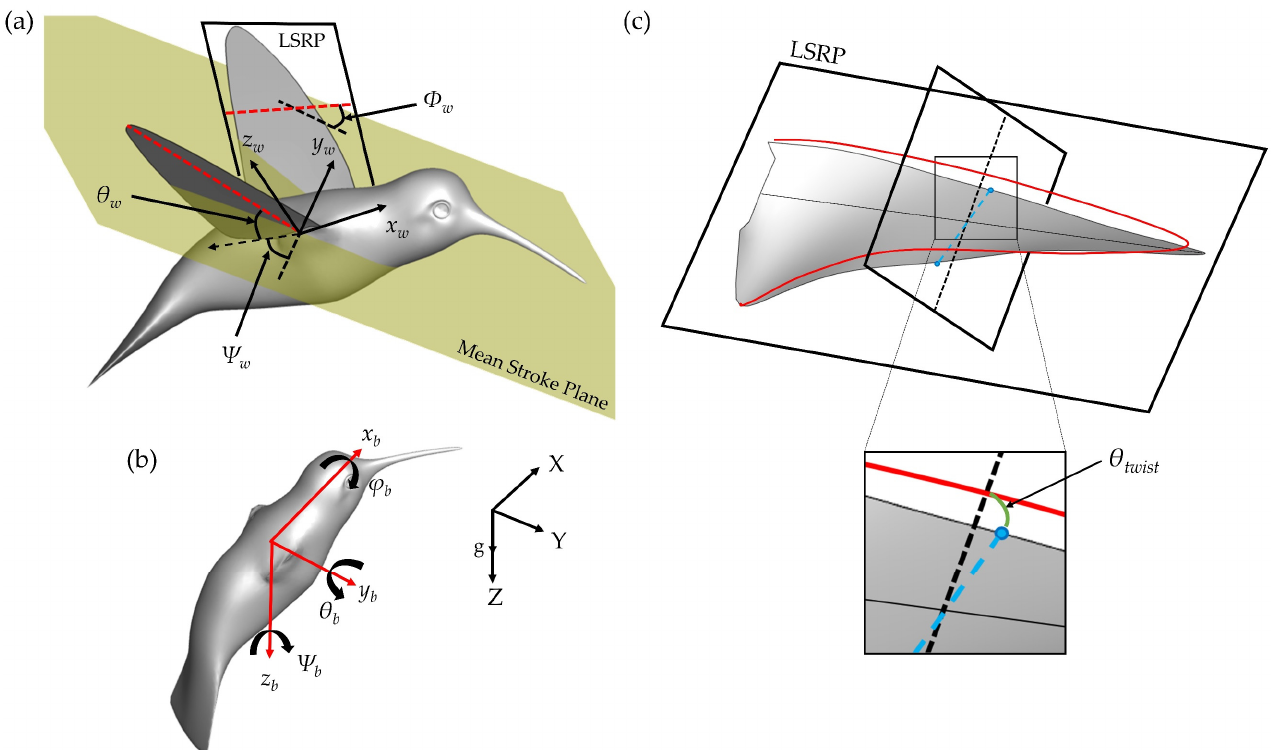
Figure 2. ( a ) Illustration of the wing kinematics angles of stroke Ψ w , deviation θ w , and pitch Φ w . The wing root-to-tip vector is shown as a dotted red line, the wing leading-edge to trailing-edge vector is shown as a dotted red line on the opposing wing; ( b ) Visualization of the body coordinate system with global reference frame pictured; ( c ) LSRP rendering with definition of θ twist as the angle between the wing and the least deformed wing